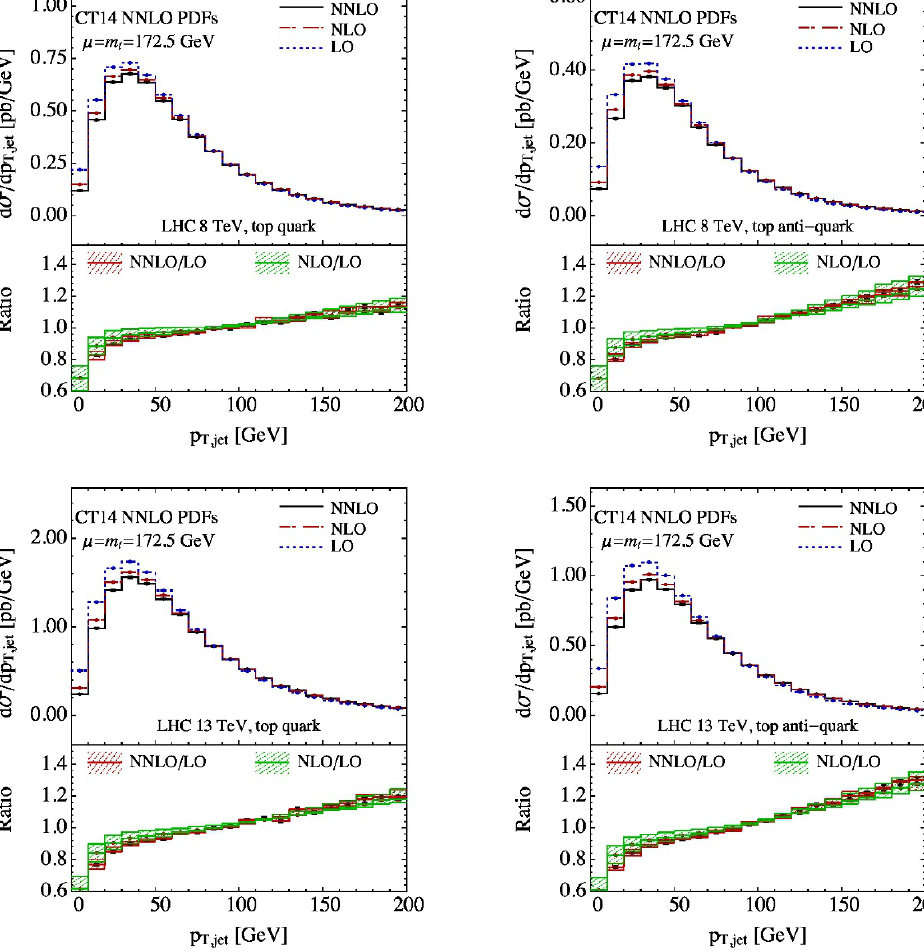
Figure 20 . Predicted transverse momentum distribution of the leading-jet from t -channel single top-quark production at 8 and 13